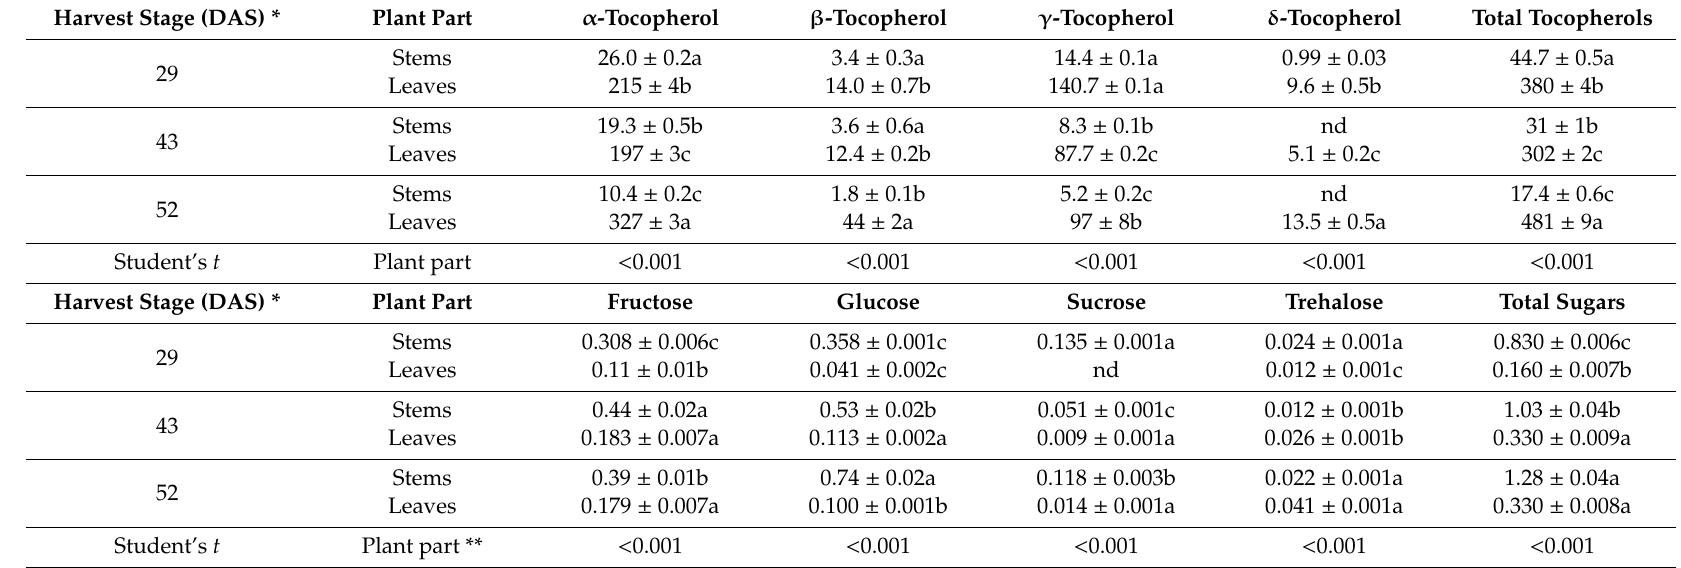
Table 2. Composition in tocopherols ( µ g / 100 g fw) and sugars (g / 100 g fw) of purslane stems and leaves in relation to harvesting stage (mean ± SD). Harvest Stage (DAS) *